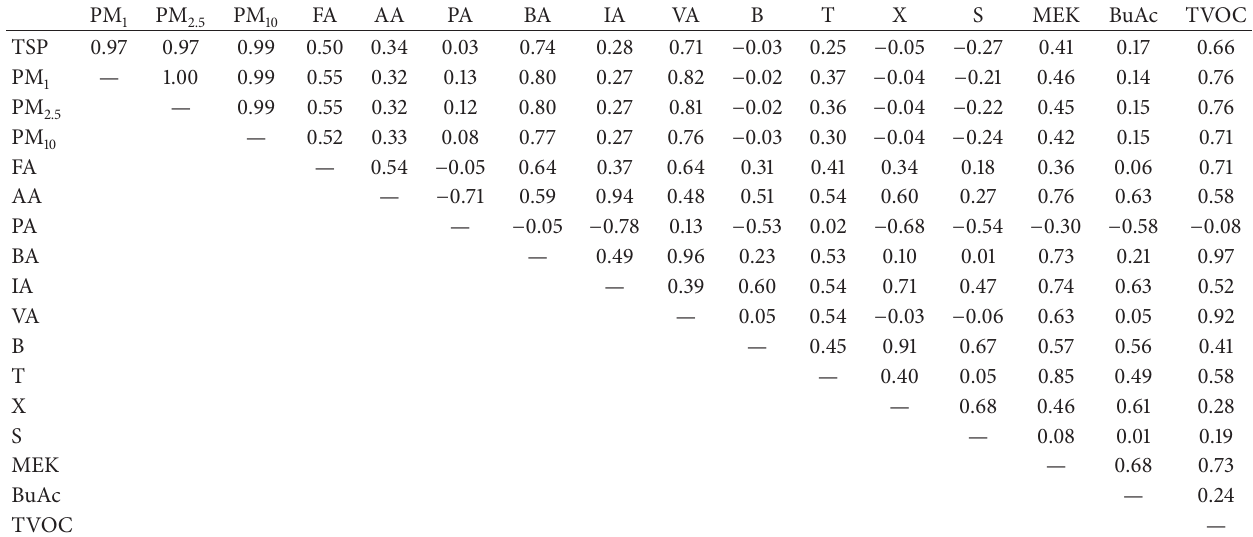
Table 4: Correlation matrix resulting from the principal component analysis of the data produced in this